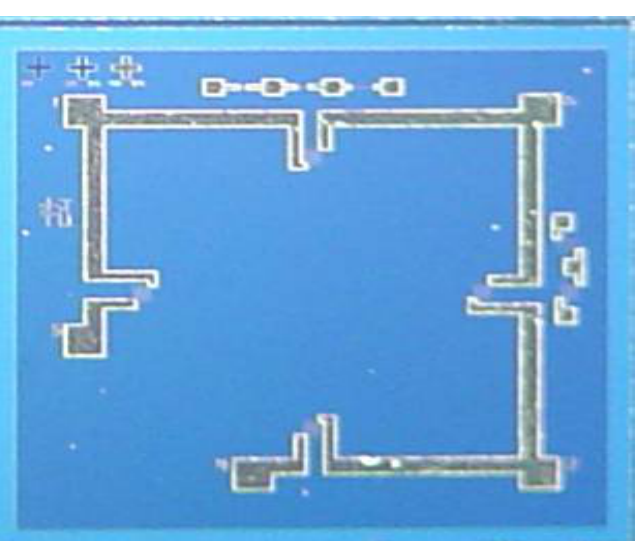
Figure 6. The fabricated sensor.